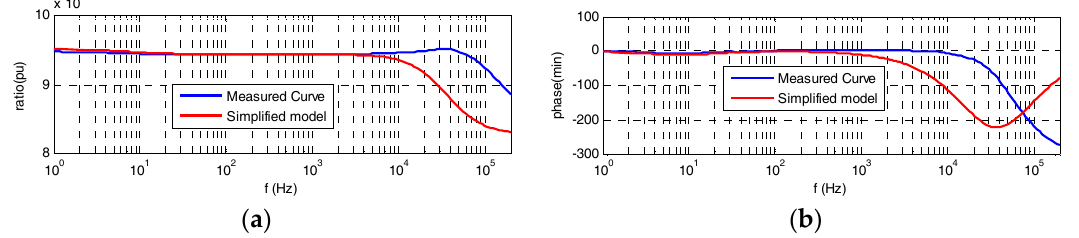
Figure 8. Frequency response curves: the red curve is obtained via Equation (9) and the blue curve was measured in the LCOE laboratory: ( a ) ratio error; ( b ) phase displacement error.